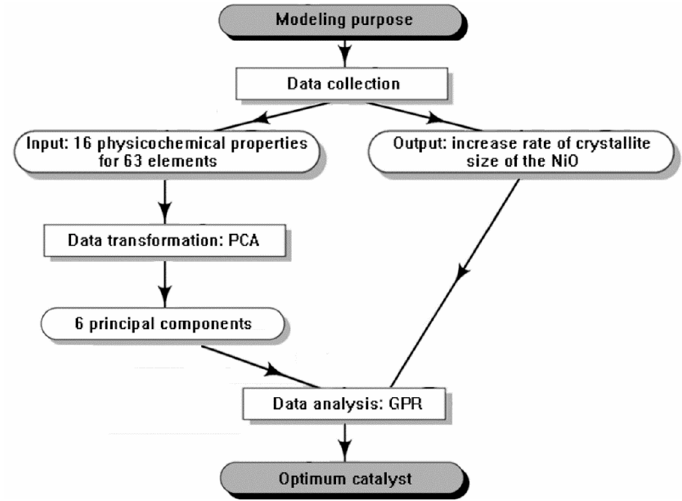
Figure 4. Flowsheet for modeling and anticipating by data-mining techniques.